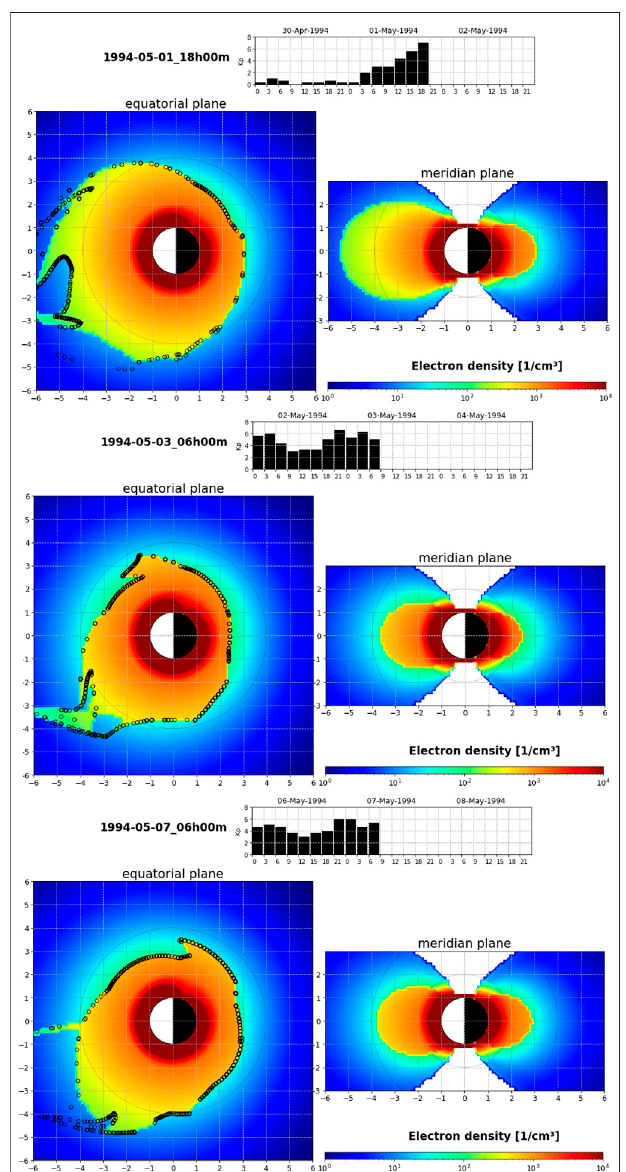
FIGURE 2 | Plasmapause (black circles) and electron number density (color scale) in the plasmasphere obtained with the SPM model in the equatorialplane (leftpanels) andinthemeridianplane (rightpanels) onMay 1, 1994 18 h UT (top) , May 3, 1994 6 h UT (middle) , and May 7, 1994 6 h UT (bottom) . These simulations are examples showing that plumes are reproduced in a continuous manner during the fi rst weeks of May